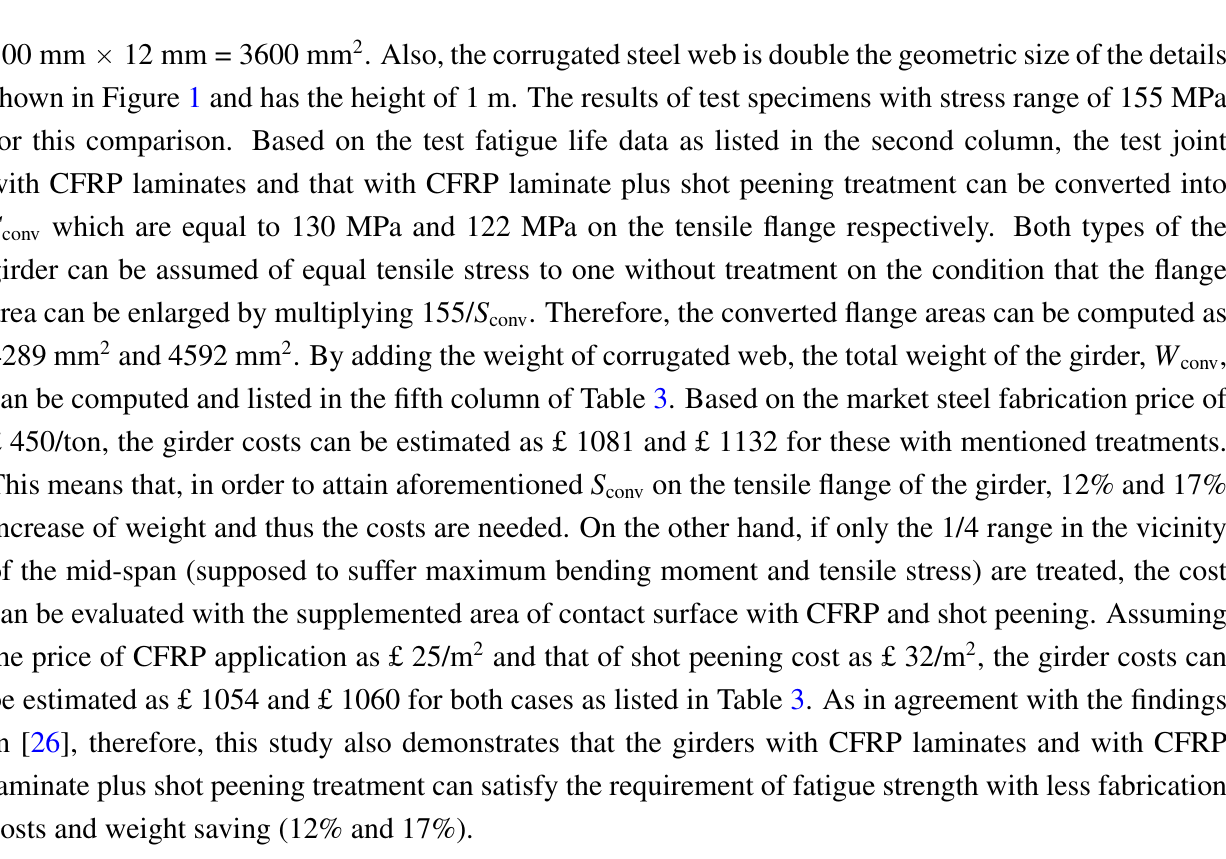
Table 3. Cost comparison of a corrugated steel web girder with or without treatment ( ∆ S = 155 MPa). Girder